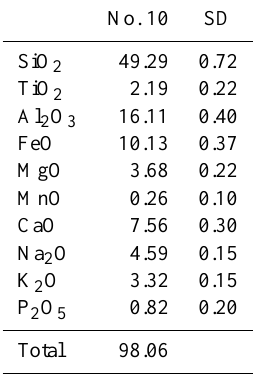
Table 1. SEM-EDS analyses of major elements in glass of 15 November 2011 ash fragments (weight % average value); no. de- notes the number of analyses; SD denotes standard deviation